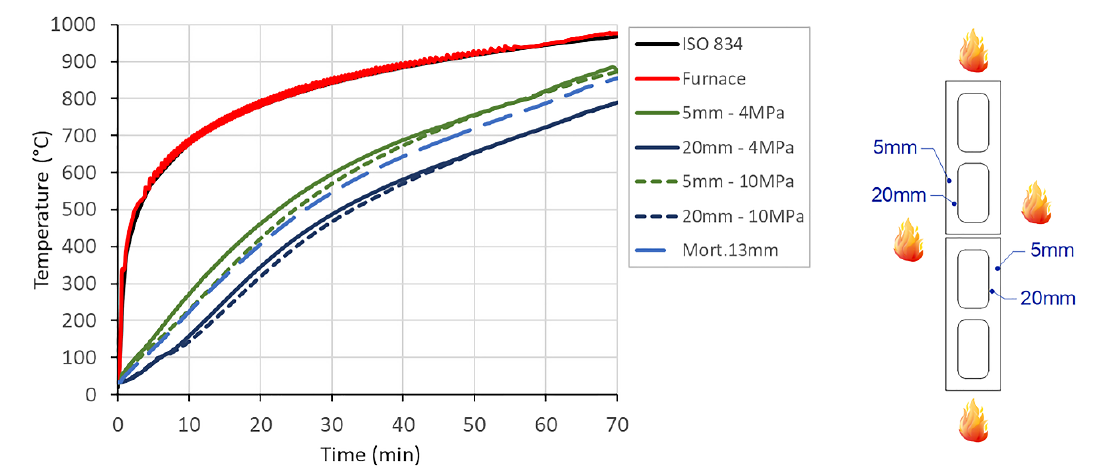
Figure 6. Small walls with fire acting on all their